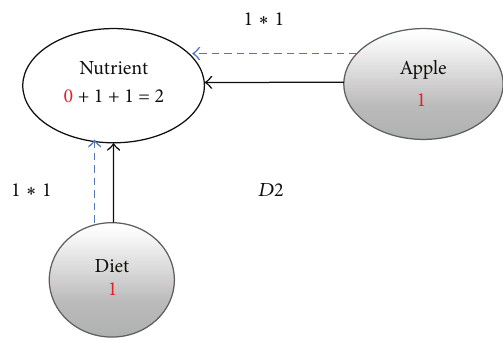
Figure 12: Spreading activation for 𝐷2 .